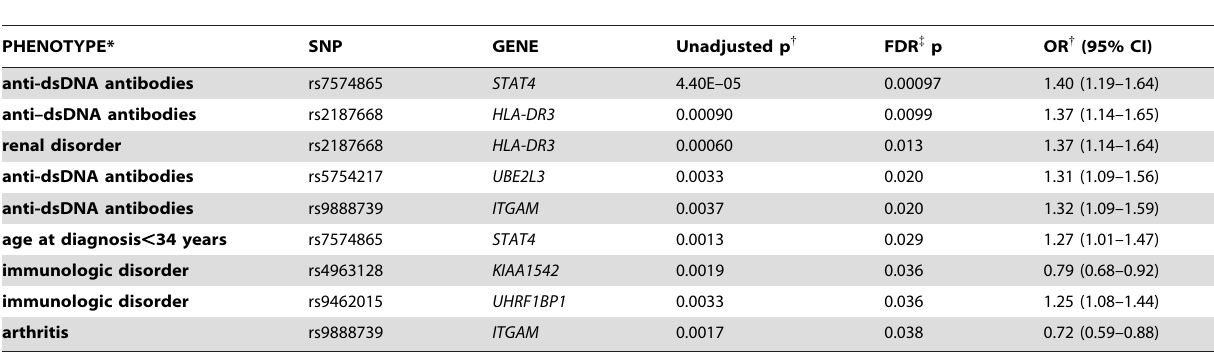
Table 2. Top associations between single risk alleles and